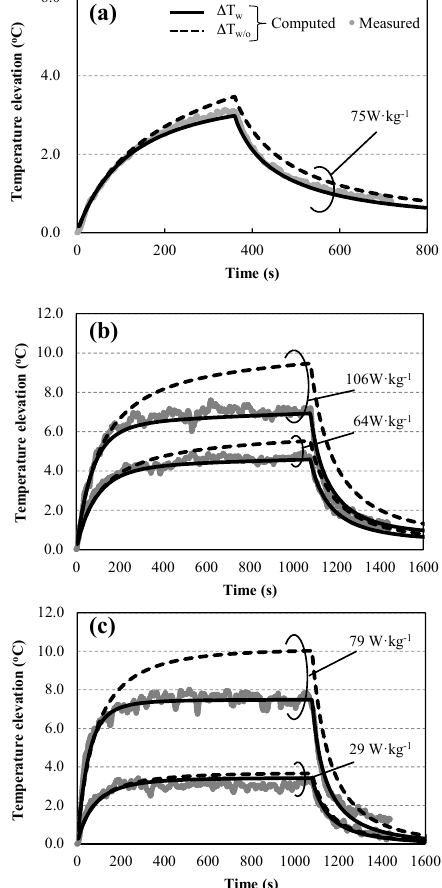
Figure 4. Comparison of temperature elevations with and without thermoregulation at different specific absorption rates averaged over the brain (BASARs): ( a ) 1.5 GHz; ( b ) 6 GHz; and ( c ) 10 GHz. The solid line shows the computed temperature with thermoregulation at the central target area ( ∆ T W ). The broken line shows the computed temperature without thermoregulation ( ∆ T W/O ). Average values of measured temperatures are plotted for comparison with computed values.